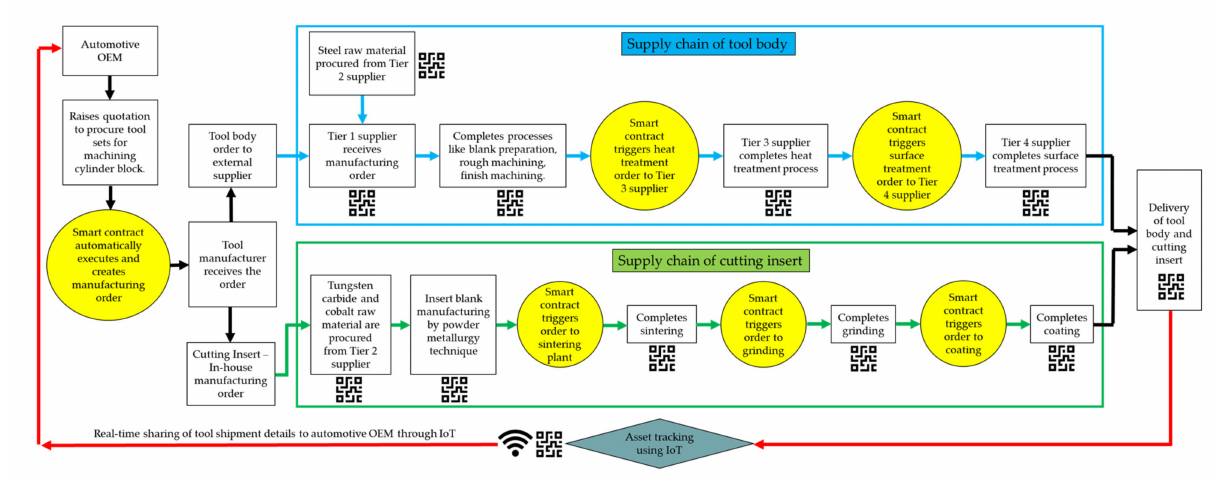
Figure 7. Flow of supply chain information between OEM, tool manufacturer, and